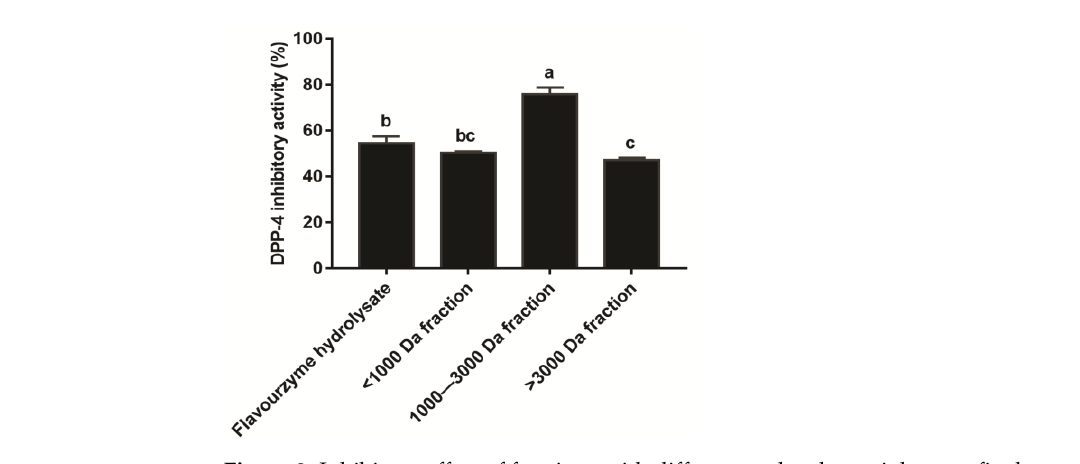
Figure 3. Inhibitory effect of fractions with different molecular weights at a final concentration of 2 mg/mL on DPP-4. Data are shown as the mean ± SD ( n = 3), and different letters mean significant difference ( p < 0.05). Table 1. The screened peptides identified from Tenebrio molitor protein hydrolysates generated by flavourzyme hydrolysis for 4 h.